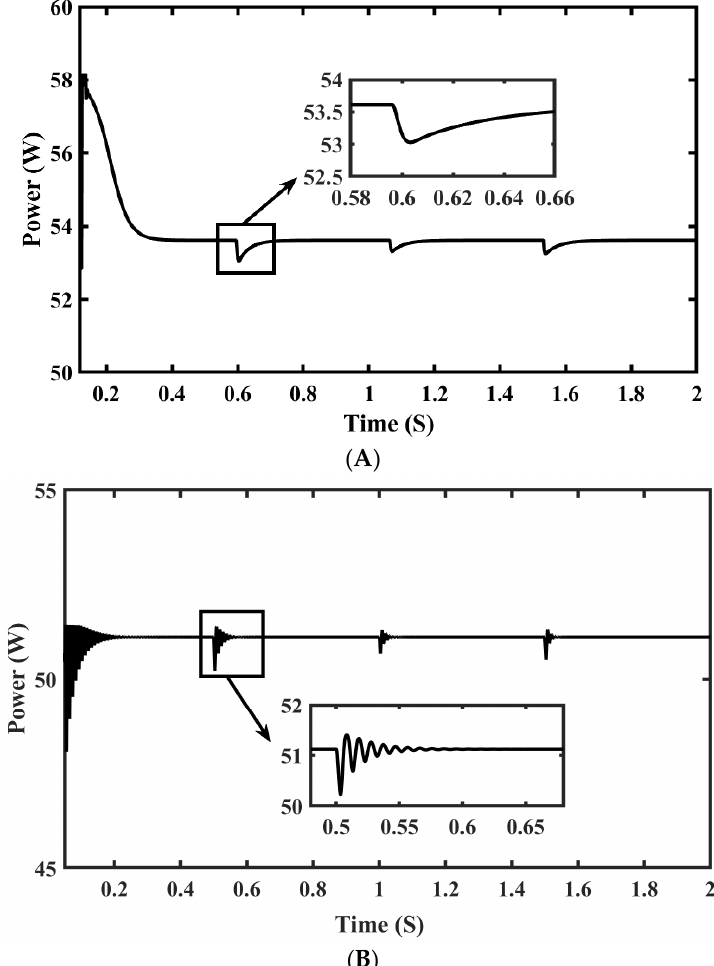
Figure 21. Experimental power transient of PV System ( A ) MLNFN TSMC ( B ) PID.